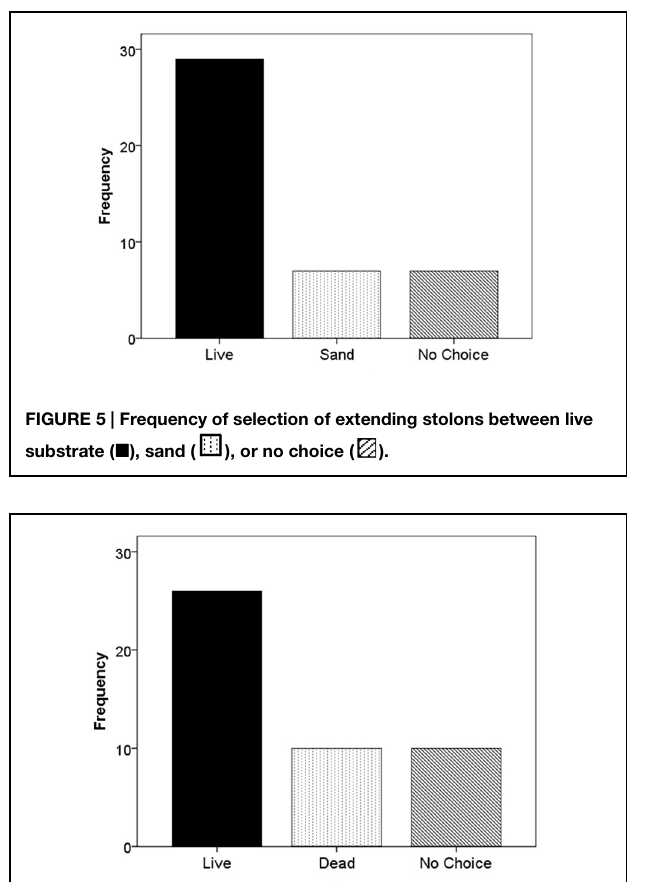
FIGURE 6 | Frequency of selection of extending stolons between live substrate ( (cid:2) ), dead substrate ( ), or no choice (